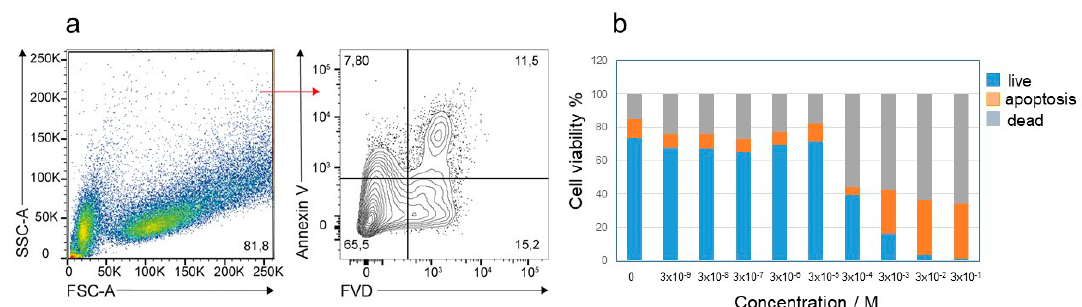
Figure 7. ( a ) RAW264.7 cells were left untreated or treated for 24 h with SB3-14 at the indicated concentrations. Cells were stained using the PerCP–Annexin V and FVD 780 and analyzed by flow cytometry. Annexin V / FVD—double negative cells (lower left quadrant) represented live cells, annexin V / FVD—double positive cells (upper left and upper right quadrant) represented apoptotic cells, and annexin V-negative / FVD-positive cells (lower right quadrant) indicated dead cells. A representative dot plot (relative to untreated cells) is shown. The percentage of viable, apoptotic, and dead cells was reported in ( b ) for each SB3-14 concentration. Data are the mean percentage of two different experiments.